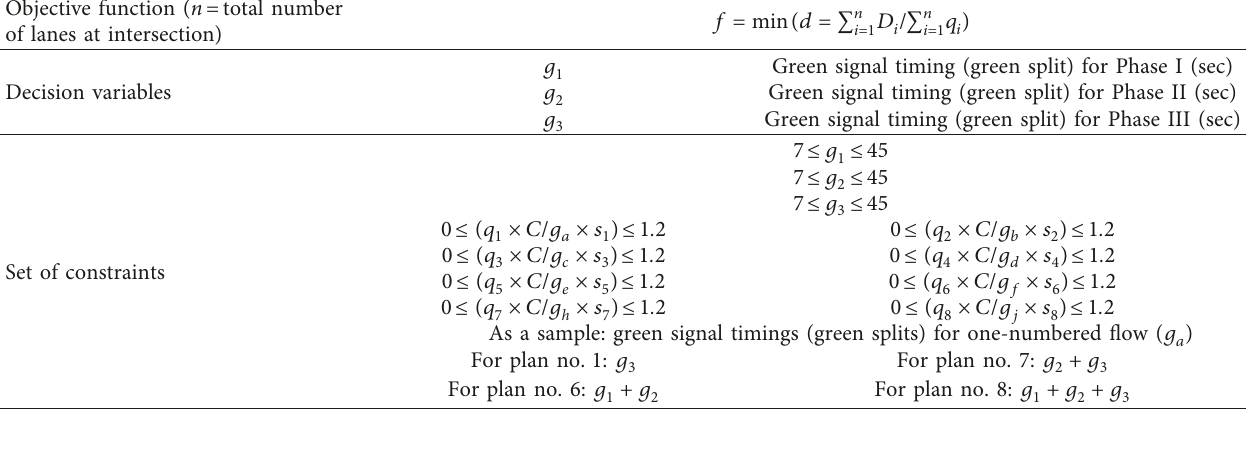
Table 2: The objective function, decision variables, and the set of constraints for the optimization problem. Objective function ( n total number (cid:31) of lanes at intersection)